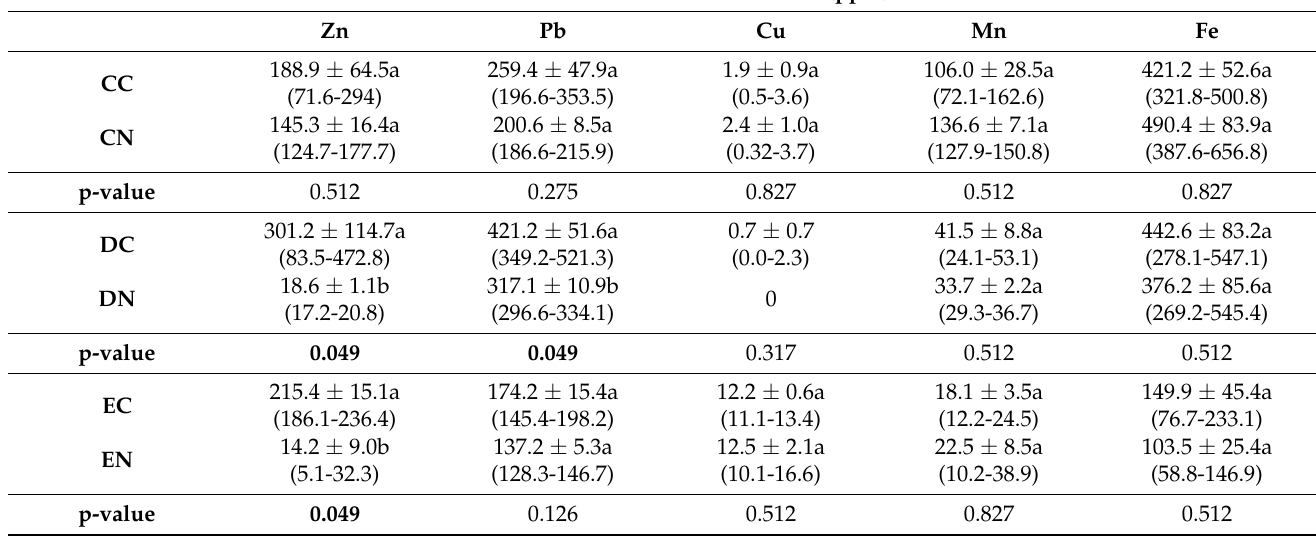
Table 3. Trace-element concentrations in roots. Mean ± SE value is indicated, and minimum and maximum values are shown in brackets. The non-parametric Kruskal–Wallis test was applied. Different letters indicate significant differences at a significance level < 0.0505 within the same element and plant species. CC = contaminated soil under C. salviifolius , CN = uncontaminated soil under C. salviifolius , DC = contaminated soil under D. viscosa , DN = uncontaminated soil under D. viscosa , EC = contaminated soil under